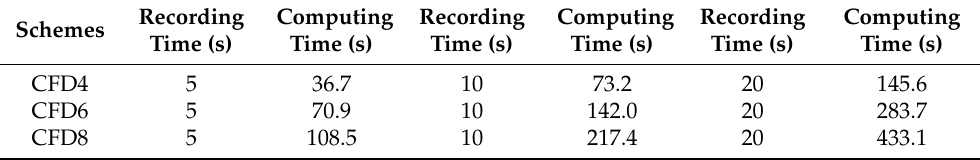
Table 4. Computing time for the CFD schemes of different orders.